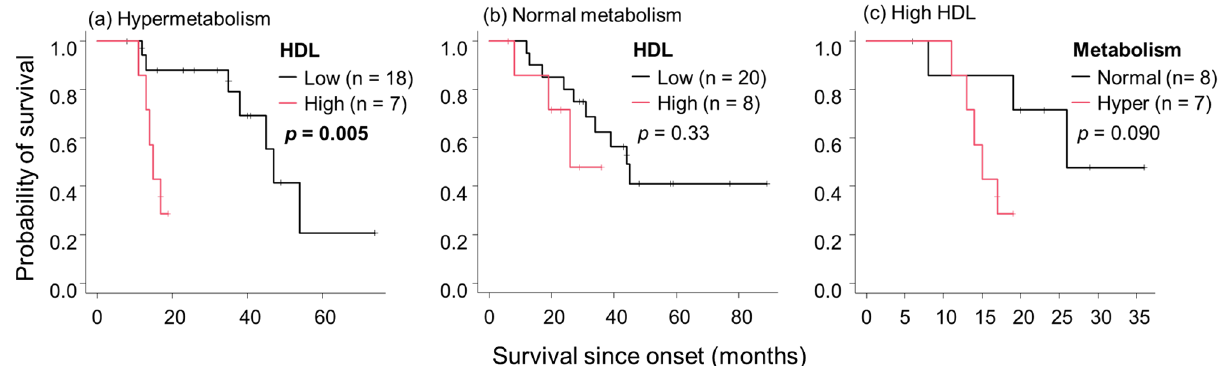
Figure 2. The relationship between HDL and hypermetabolism in terms of survival. Kaplan–Meier analyses and log-rank tests revealed that among patients with hypermetabolism, those with high HDL had significantly shorter survival ( a ), which was not the case in patients with normal metabolism ( b ). Patients with hypermetabolism had shorter survival than patients with normal metabolism in the high HDL group, although this finding was not significant ( c ). Abbreviations: HDL, high-density